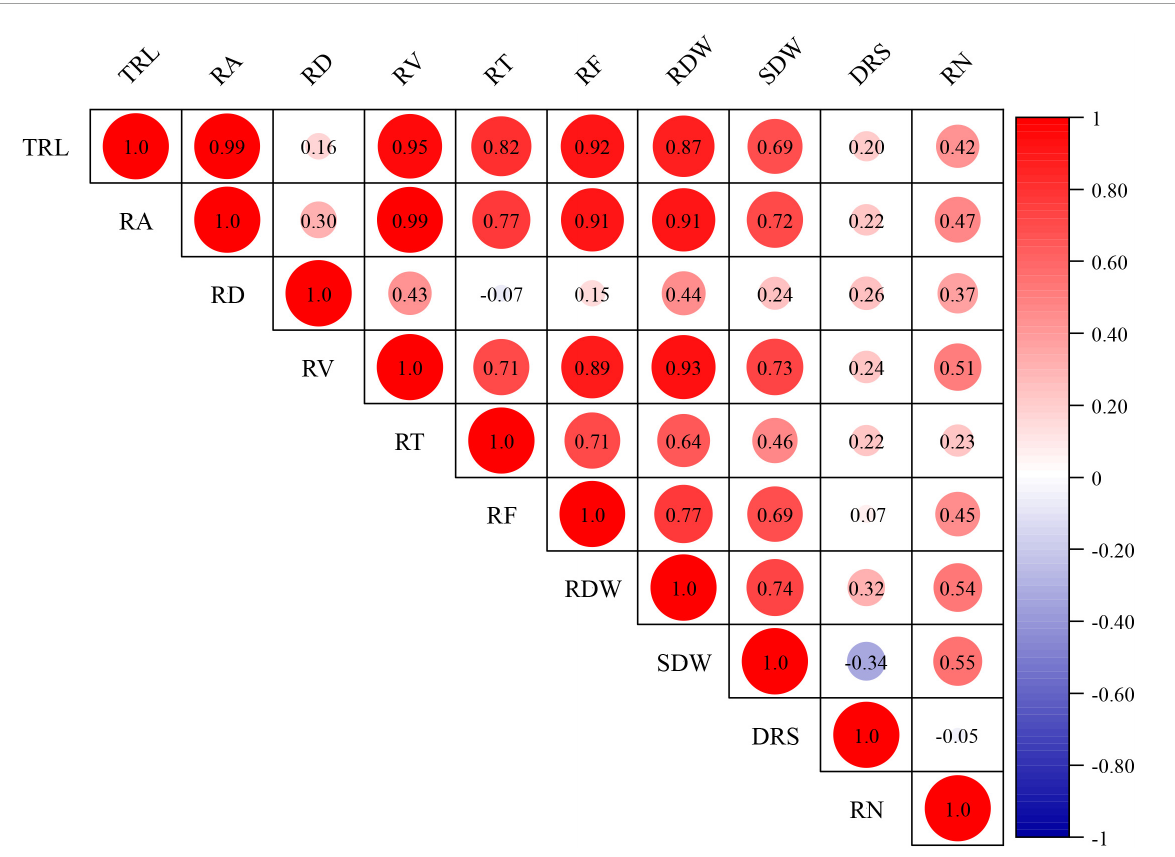
FIGURE2 Correlation coefficients for RSA-related traits. TRL total root length, RA root area, RV root volume, RD root diameter, RT root tips, RF root forks, RDW root dry weight, SDW shoot dry weight, DRS dry root–shoot ratio, RN root number. The BLUP datasets were used to evaluate the correlation coefficients for RSA-related